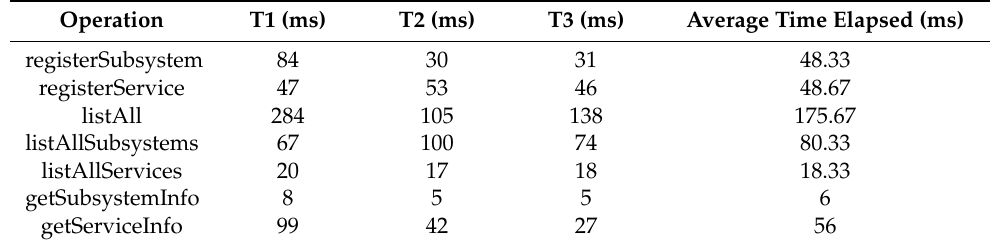
Table 4. Response time when there are 100 subsystems and services registered.